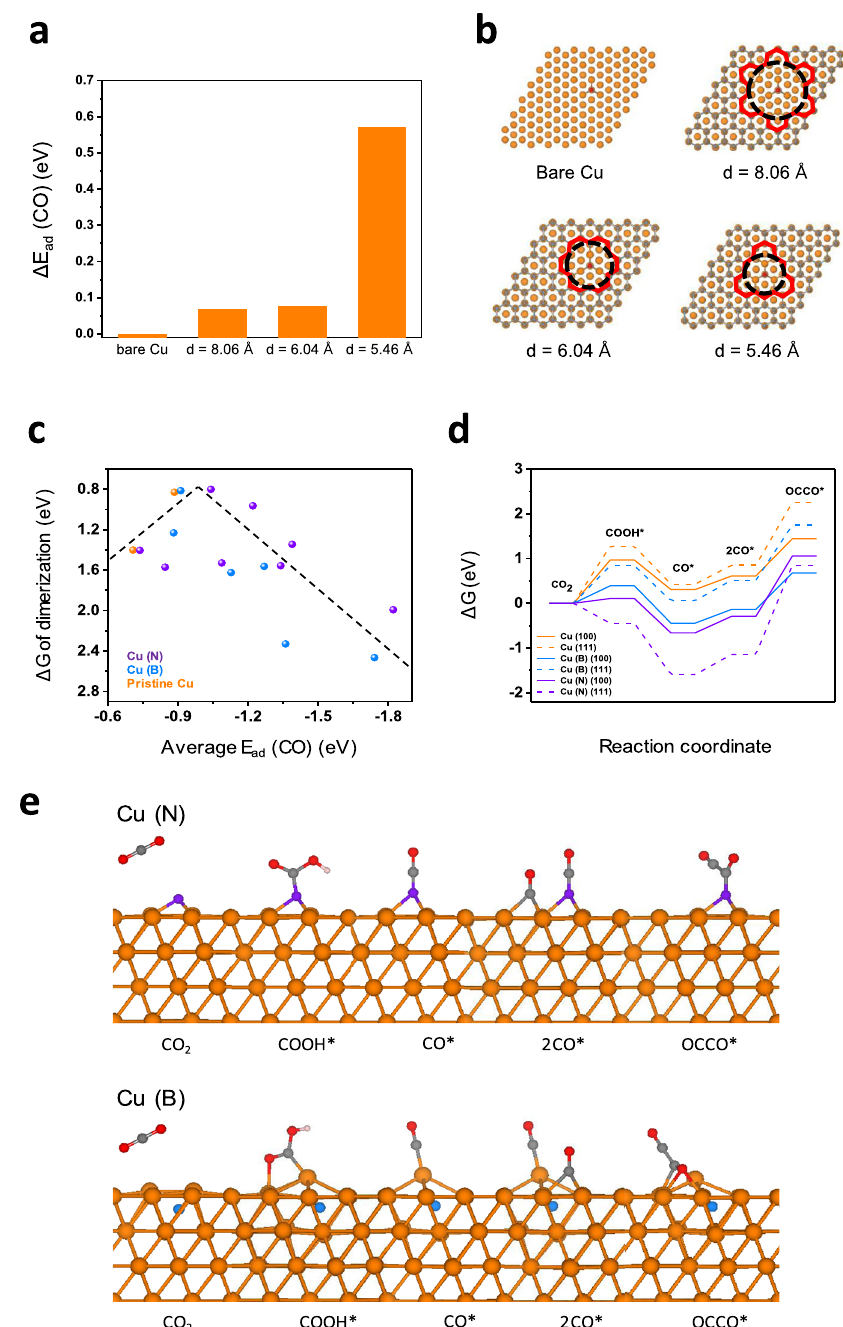
Fig. 5 DFT calculations to determine the effect of the C shell and dopant on the catalytic activity of Cu. a Difference in the CO adsorption energies ( Δ E ad ) of the Cu (111) surface without a C layer and Cu (111) surface encapsulated by a C layer with pore sizes of 8.06, 6.04, and 5.46 Å . b Atomic structures for each case. The red line marks a pore in the C layer. The pore size corresponds to the diameter of the black dashed circle. c Δ G of CO dimerization as a function of the average CO adsorption energy. d Free energy diagram for CO dimerization on the pristine Cu, Cu (B), and Cu (N) surfaces. e Proposed dimerization mechanism for C 2 H 4 formation on Cu (N) (111) and Cu (B) (111). Orange, blue, purple, gray, and red spheres represent Cu, B, N, C, and O atoms,